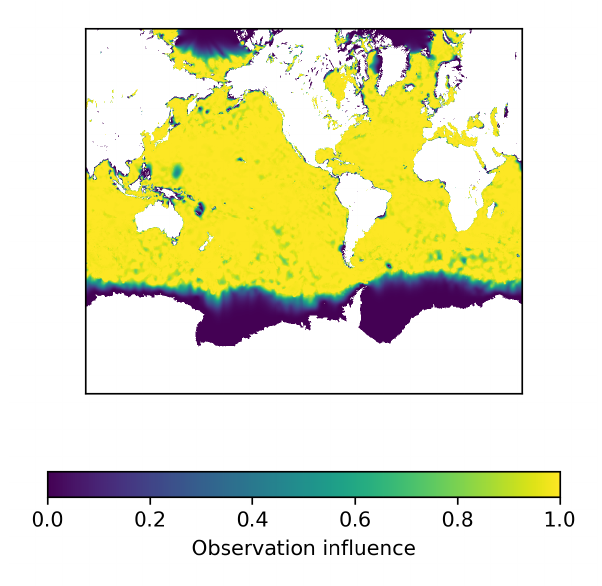
Figure 9. Example of an observation influence